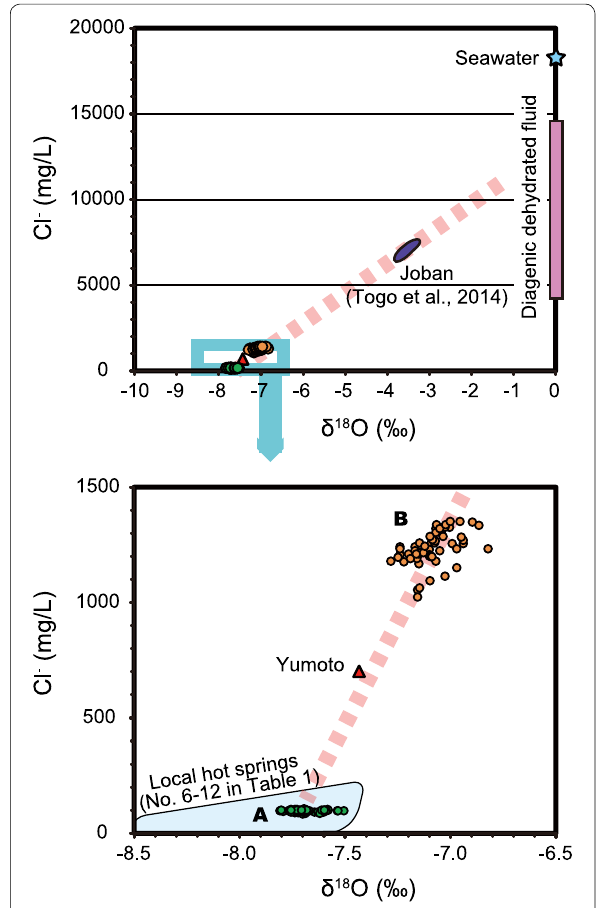
Fig. 4 Relationship between Cl − concentration and δ 18 O in hot spring water. Light blue and purple areas indicate hot spring plot ranges from No. 6 to 12 in Table 1 and the Joban plot range by Togo et al. (2014), respectively. Thick dotted line shows possible mixing line of hot spring water in Iwaki